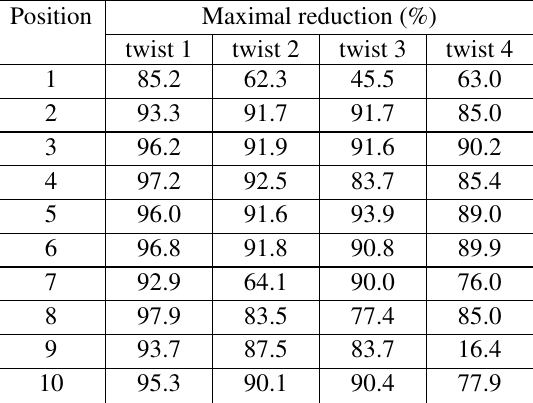
Table 2. Maximal reduction for the first four twist mode shapes